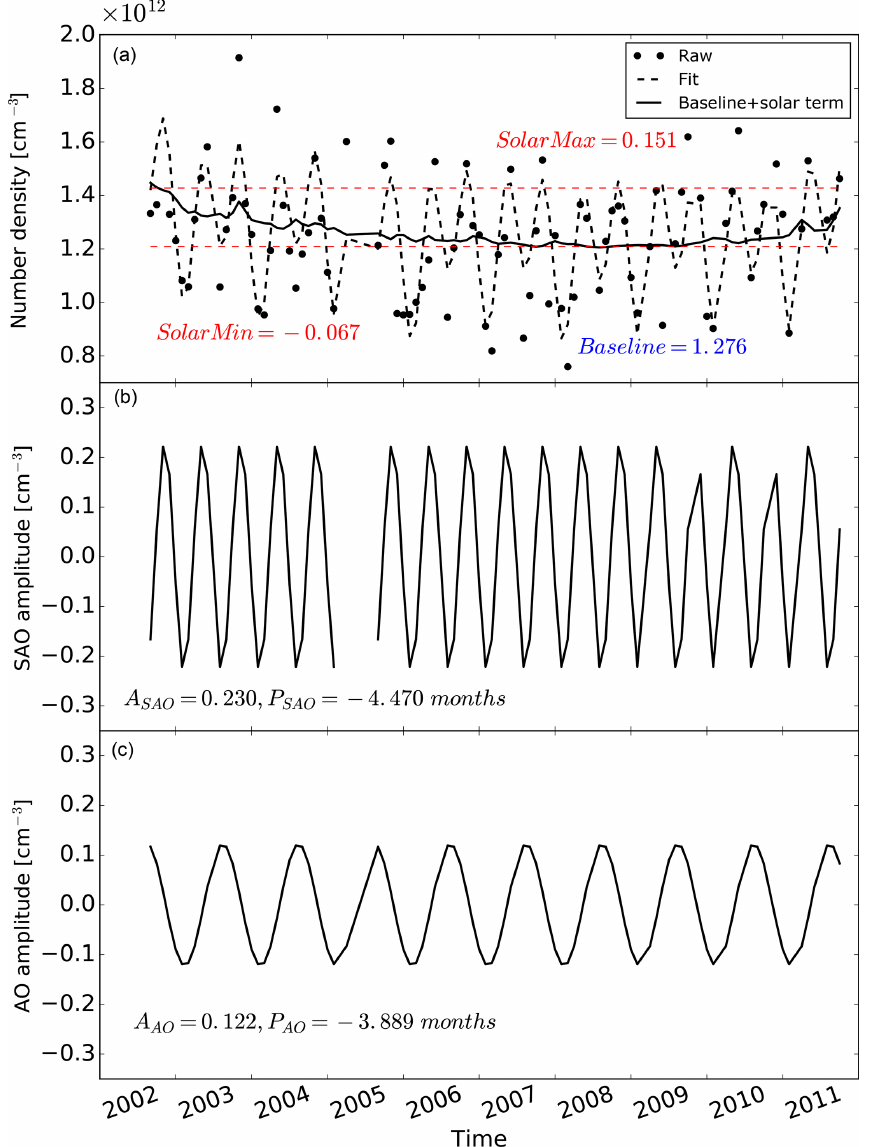
Figure 10. Multiple linear regression analysis of vertically integrated, monthly mean atomic oxygen densities of 80–97km for 20–30 ◦ N from 2002 to 2011. (a) The raw and fitted data are shown along with the baseline plus the solar components in the multiple linear regression results. The solar min and solar max values denote the fitted atomic oxygen column densities solely from the solar cycle component, under the solar minimum and solar maximum conditions, respectively. (b) SAO and (c) AO parts are also illustrated with corresponding parameters. A SAO , P SAO , A AO and P AO are the amplitudes and phase shifts of SAO and AO, respectively. The quantities of solar min, solar max, baseline and amplitudes are in units of 10 12 atomscm − 3 . The phase shifts are in units of months. The gap present in the SAO is caused by the data